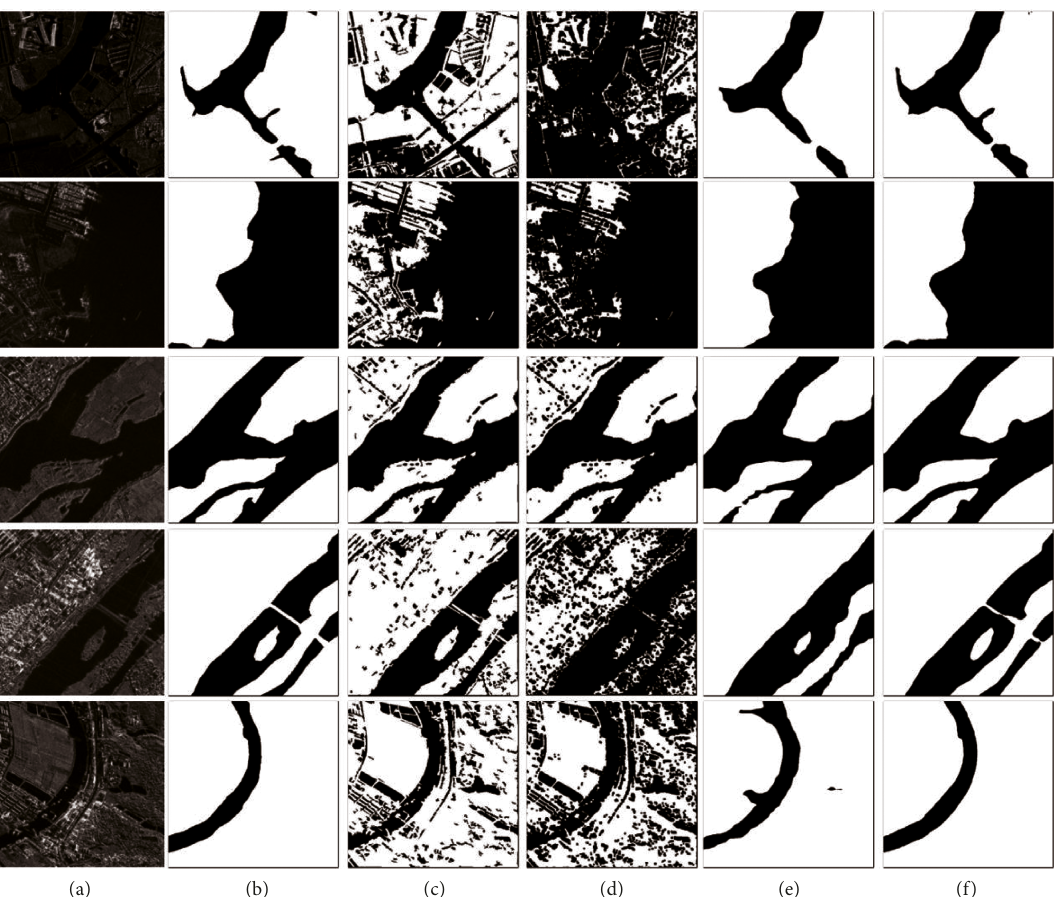
Figure 17: Experimental results of different methods. (a) Input image. (b) Ground truth. (c) Levelset. (d) Otsu. (e) Unet. (f) Proposed